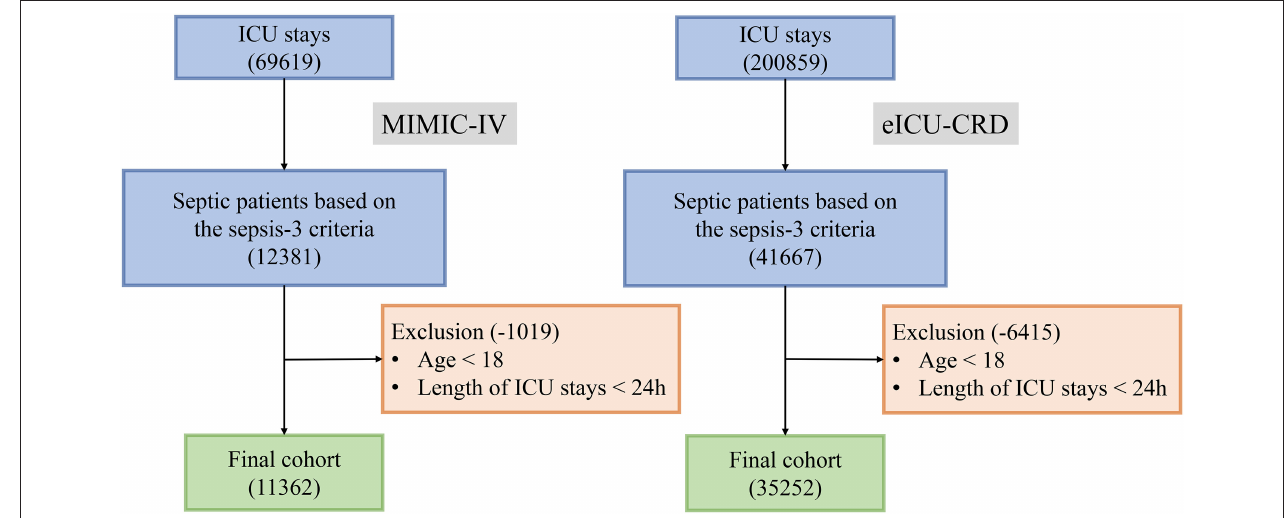
FIGURE 2 | Flow chart of patient selection.